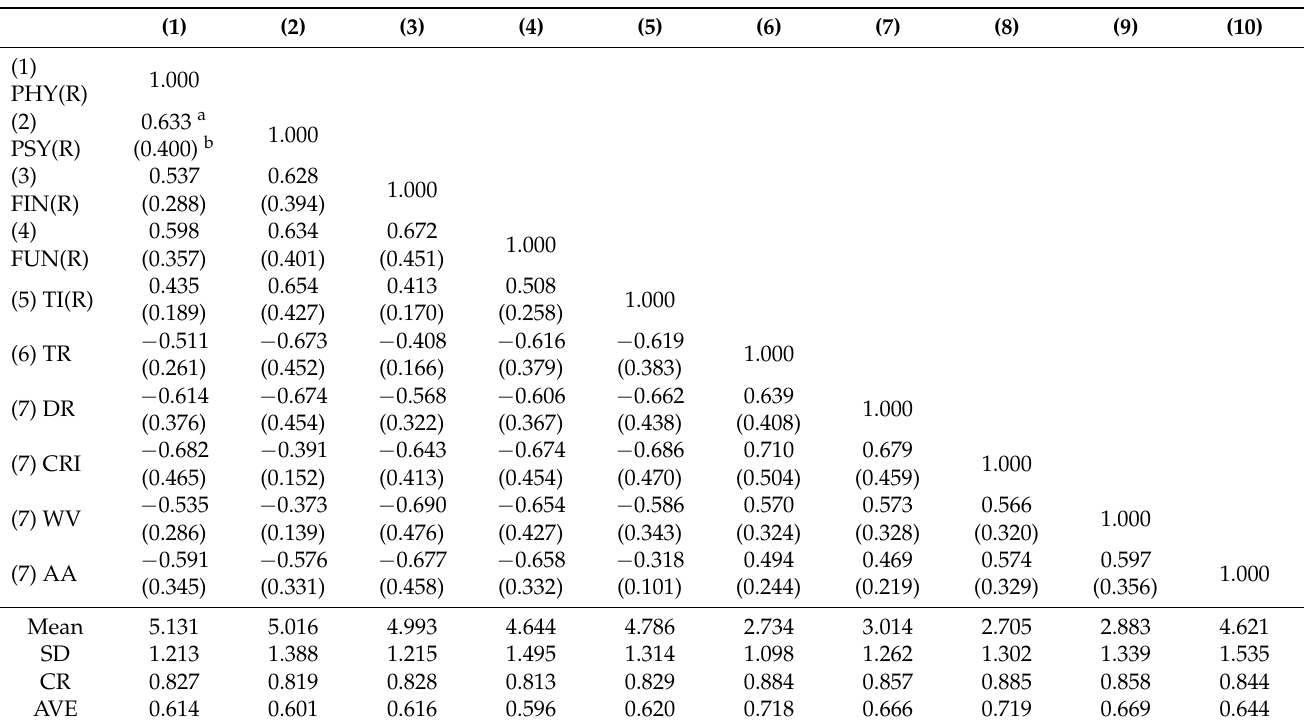
Table 1. Measurement model results and